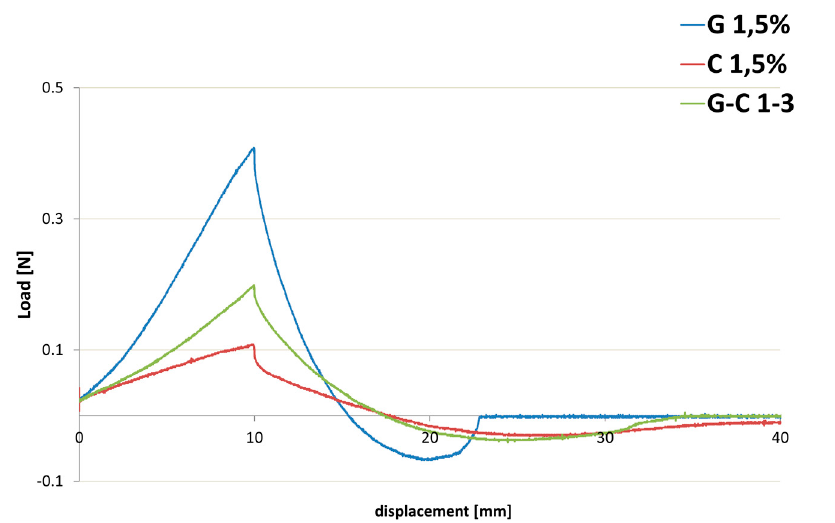
Figure 12. Texture curves obtained by an immersion/de-immersion test performed on the samples prepared with G, C, and the G–C association (1:3) at the same total polymer amounts (1.5% w/w).